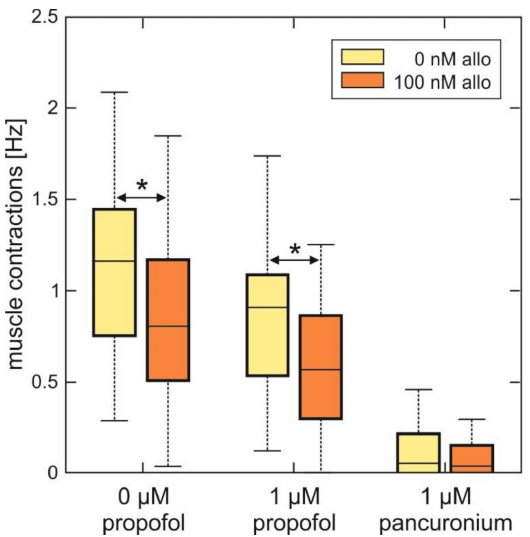
Figure 5. Summary of the e ff ects of allopregnanolone on muscle contraction frequency in spinal nerve and muscle co-cultures in the absence and in the presence of propofol. As data were not normally distributed (Lilliefors test), data are given as boxplots. Left side: 100 nM ALLO significantly reduced the muscle contraction frequency in spinal nerve and muscle co-cultures from 1.16 (0.84, 1.29) Hz under control conditions to 0.81 (0.70, 0.95) Hz ( n = 29, Mann-Whitney U test, * p = 0.043). Middle: while propofol (1 µ M) also reduced the median muscle contraction frequency (0.92 (0.55, 1.04) Hz, n = 29), this e ff ect significantly increased in the additional presence of 100 nM ALLO: median muscle contraction frequency 0.56 (0.32, 0.78) Hz, n = 28, Mann-Whitney U test, * p = 0.041, compared with propofol. Right side: muscle contractions are virtually absent in the additional as well as in the sole presence of 1 µ M pancuronium.